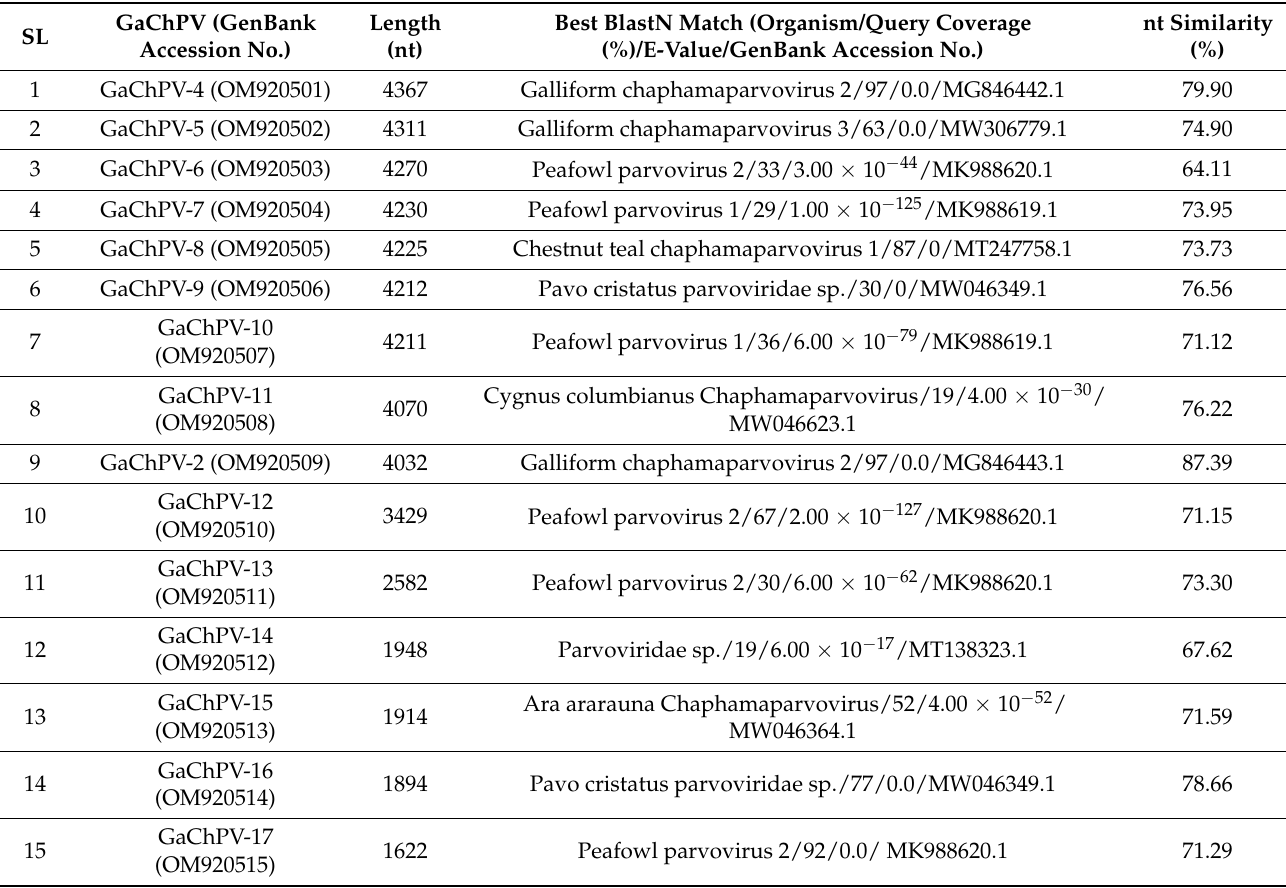
Table 1. Comparative analysis of galliform chaphamaparvovirus (GaChPV) sequenced in this